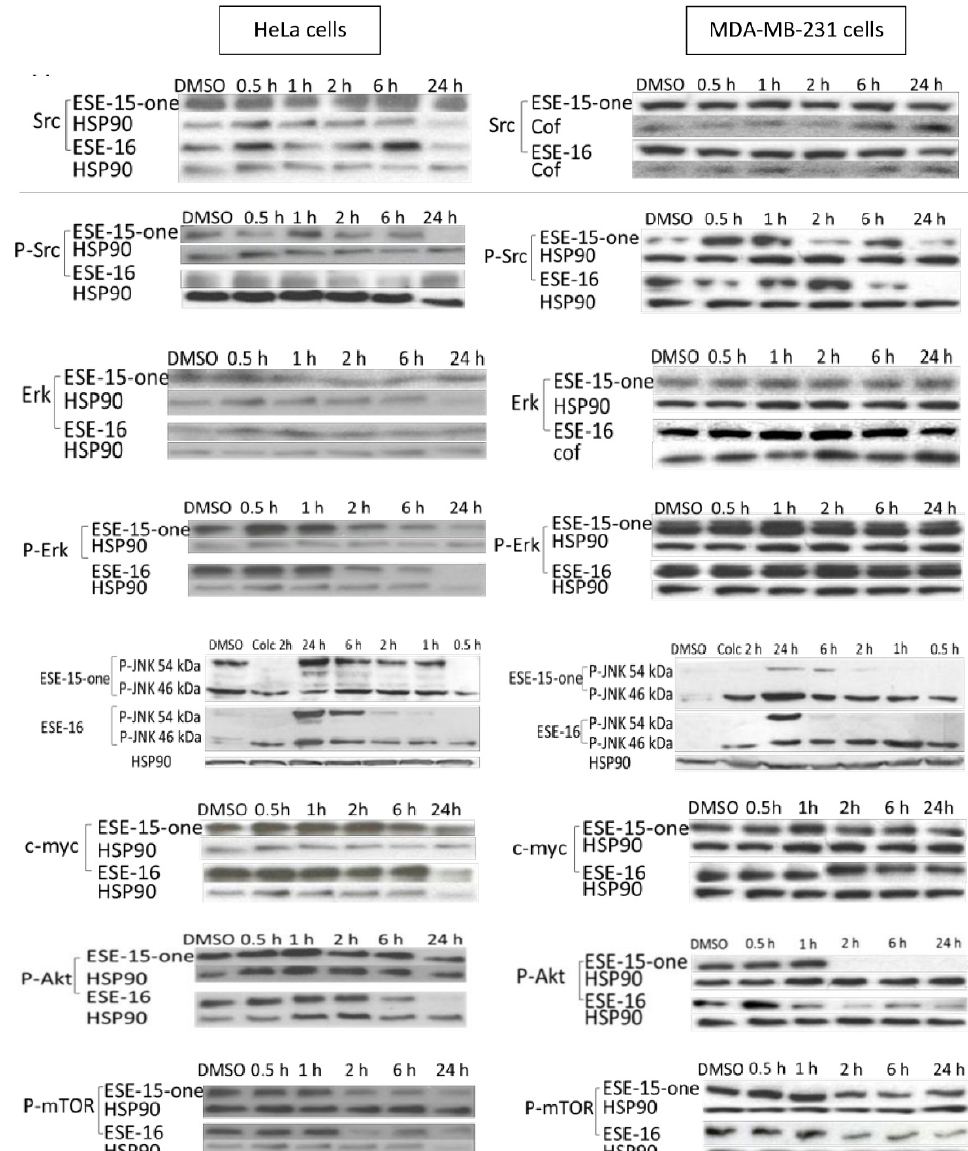
Figure 10. Western blot analysis of the temporal activation of proteins investigated to understand the signalling cascades initiated by ESE-15-one and ESE-16 treatment of HeLa and MDA-MB-231 cells, as indicated. JNK (c-Jun N -terminal kinase) exists in three isoforms, JNK 1, -2 and -3, the former being distinguished by their size, namely 46 kDa and 54 kDa, respectively [34,35]. HeLa cells exposed to ESE-15-one and ESE-16 displayed incremental phosphorylation of the 54 kDa isoform over 24 h, with the strongest activation at 24 h (Figure 10). The